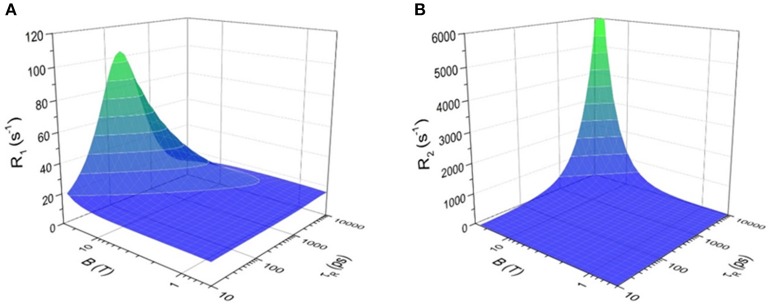
Effect of applied magnetic field, B, and the rotational correlation time, τR on (A) longitudinal relaxation rate (R1) and (B) transverse relaxation rate (R2) of 19F nuclei in [Tm-DOTAm-F12]3+. The analysis is based on Equation (1) for R1 or (2) for R2 and is done at 37°C using the mean 19F–TmIII distance determined from X-ray crystallography (6.26 Å), assuming a magnetic moment, μeff, of 7.6 BM and an electronic relaxation time, τe, of 0.20 ps, values typical of TmIII complexes.